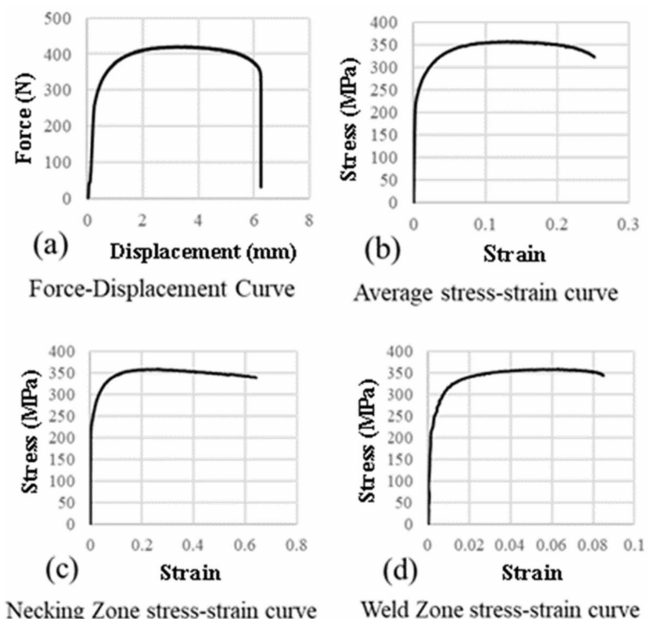
Figure 11. Diagrams showing ( a ) force − displacement curves and ( b – d ) stress − strain curves repre- senting various stages/places during tensile testing on the 200 µ m thick foil, with 100 W of power and at a speed of 30